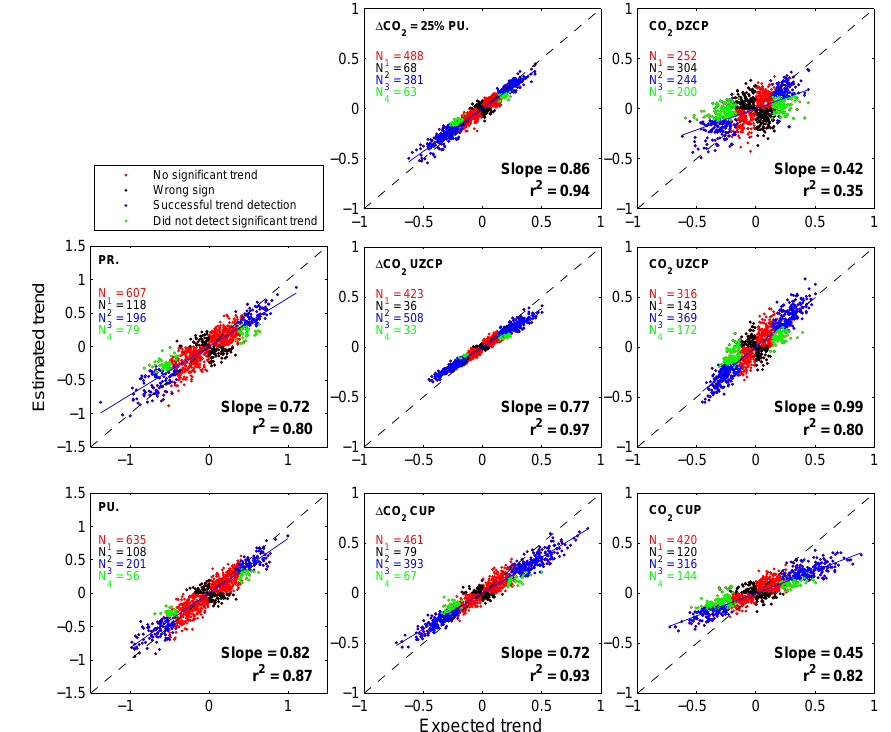
Figure B7. Regression of expected and estimated linear trends for peak uptake (PU), peak release (PR), and the (cid:49) t CO 2 and CO 2 phase metrics. Coloured points represent (red) trends that were not statistically significant, (black) trends where we estimated the incorrect sign of the trend, (blue) statistically significant trends that were successfully detected, and (green) statistically significant trends that were not detected in the analysis. Statistical significance is at the 5% level. The numbers, N 1 ...n are the number of points in each category and sum to 1000.